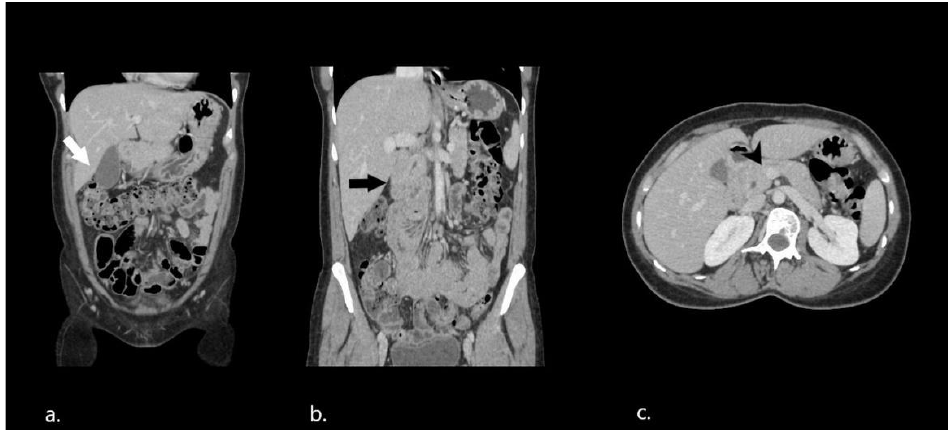
Figure 4. Postoperative abdominal CT. ( a , b ) Coronal reformatted images depicting no small bowel loops located above and to the right of the transverse colon (white arrow) and malrotated duodenum and jejunum loops on the right side of the abdomen (black arrow). ( c ) Restoration of the normal course of the superior mesenteric vein (black arrowhead .